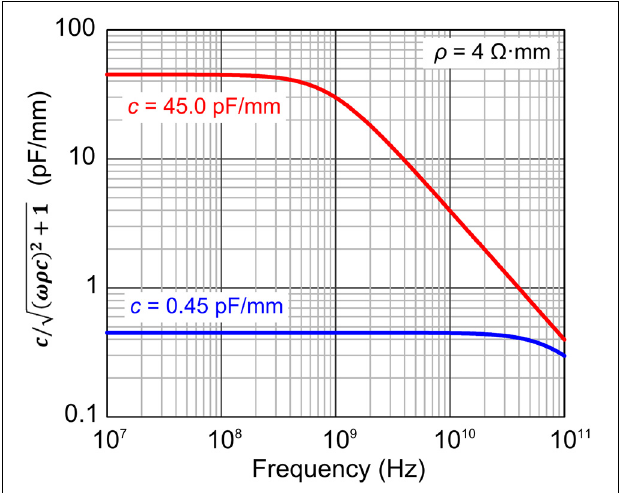
(cid:2) (ωρ c ) 2 + 1 on frequency, which is a part FIGURE 4 | Dependence of c / of V π L. Forward (red) and reverse (blue) biased operations are assumed.